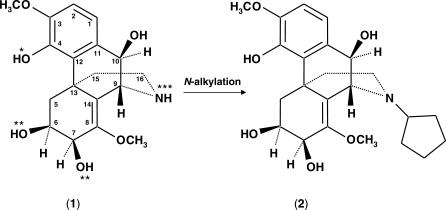
Structure of TazopsineTazopine is shown on the left. The chemically modified substituents are indicated by asterisks (left): a single asterisk (*) indicates 4-OH protected by 4-O-alkylations; double asterisks (**) indicate 6,7-diol protected by an acetonide ketal; and triple asterisks (***) indicate secondary amine substituted by N-acetylation and N-alkylations. Structure of the semisynthetic alkaloid, NCP-tazopsine is shown on the right.